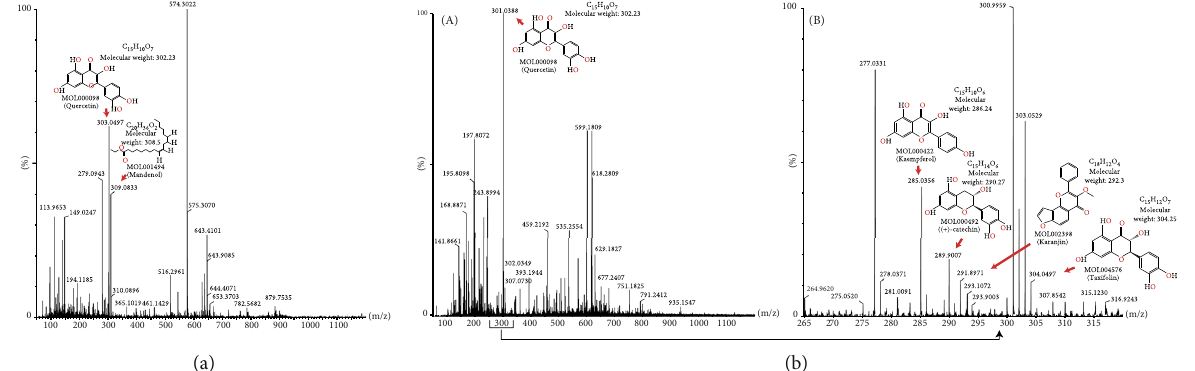
Figure 7: The results of UPLC – MS/MS. (a) The MS monitoring was run in positive ion mode. (b), (A) The MS monitoring was run in negative ion mode. (B) MS results for compounds with m/z between 265 and